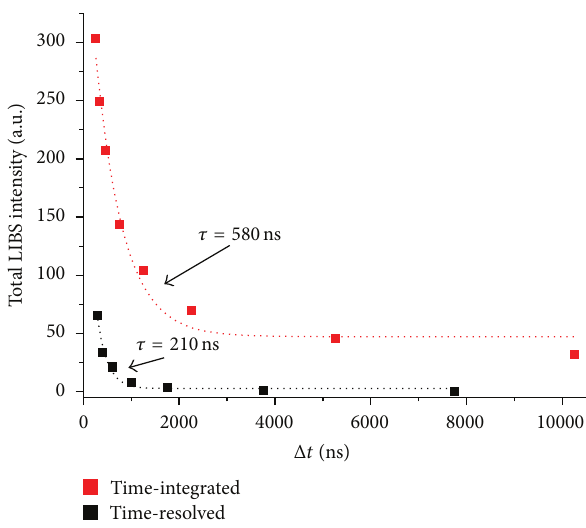
Figure 7: Dependence of the LIBS signal on the acquisition delay. The dashed curves represent the best fit of the data with an exponential function. Red circles: Al I line at 281.6nm; black squares: Al II line at 358.6 nm.